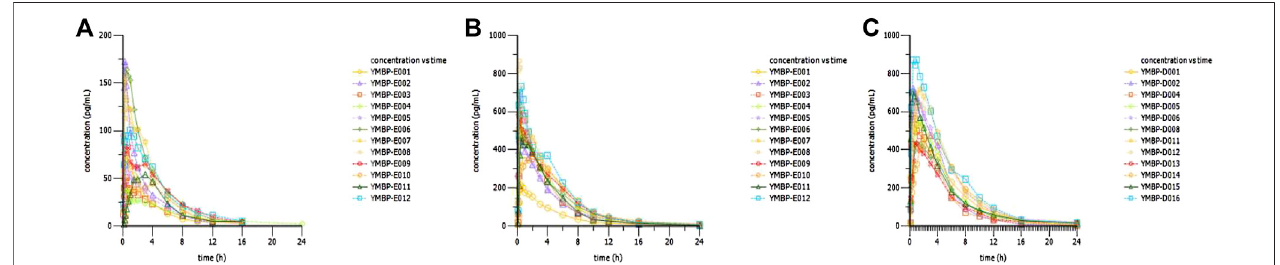
FIGURE 3 | Concentration – time curves of dexmedetomidine in healthy subjects following a single dose of dexmedetomidine nasal spray. (A) 20 μ g in Part 3. (B) 100 μ g in Part 3. (C) 150 μ g in Part 2.